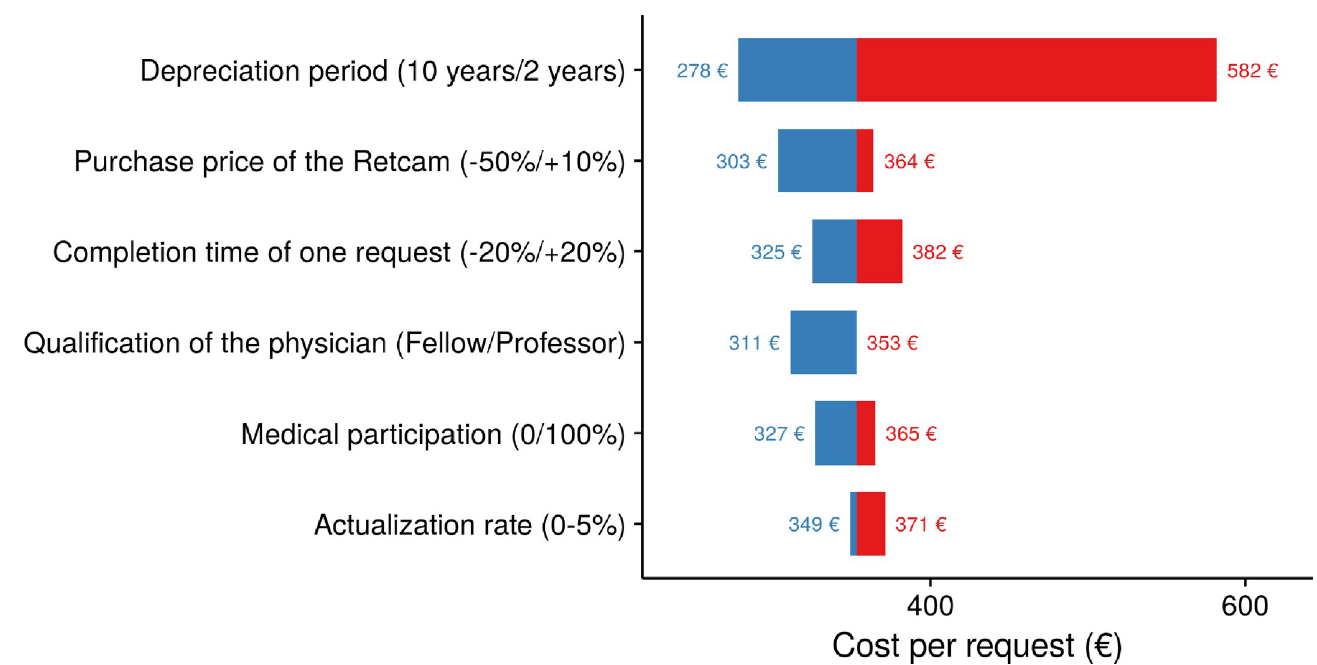
Fig 4. Sensitivity analysis–baseline € 353 tele-expertise